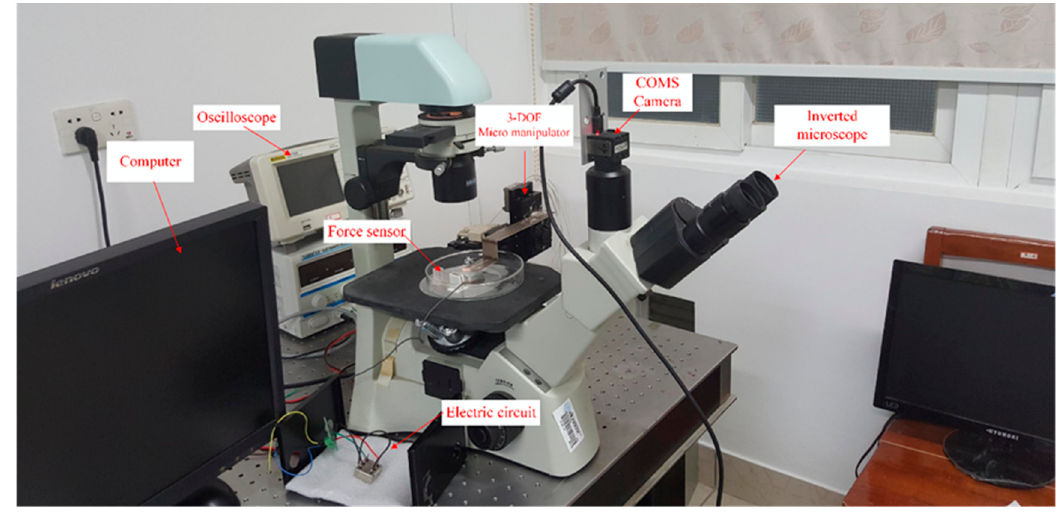
Figure 12. Experimental set-up for zebrafish embryo injection force measurement. 3-DOF, three degrees of freedom.